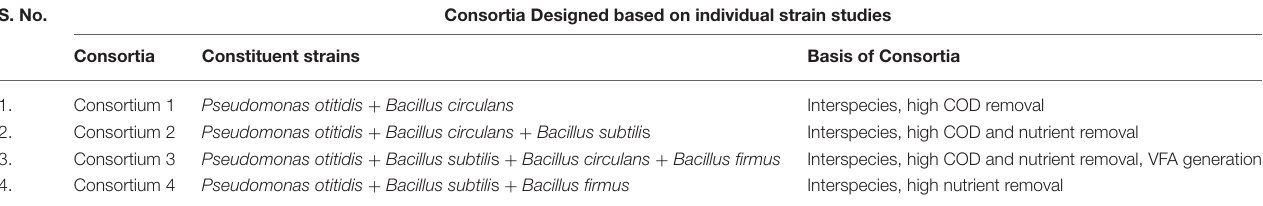
TABLE 2 | Synthetic consortia composition designed based on the individual isolated strains study. S. No.